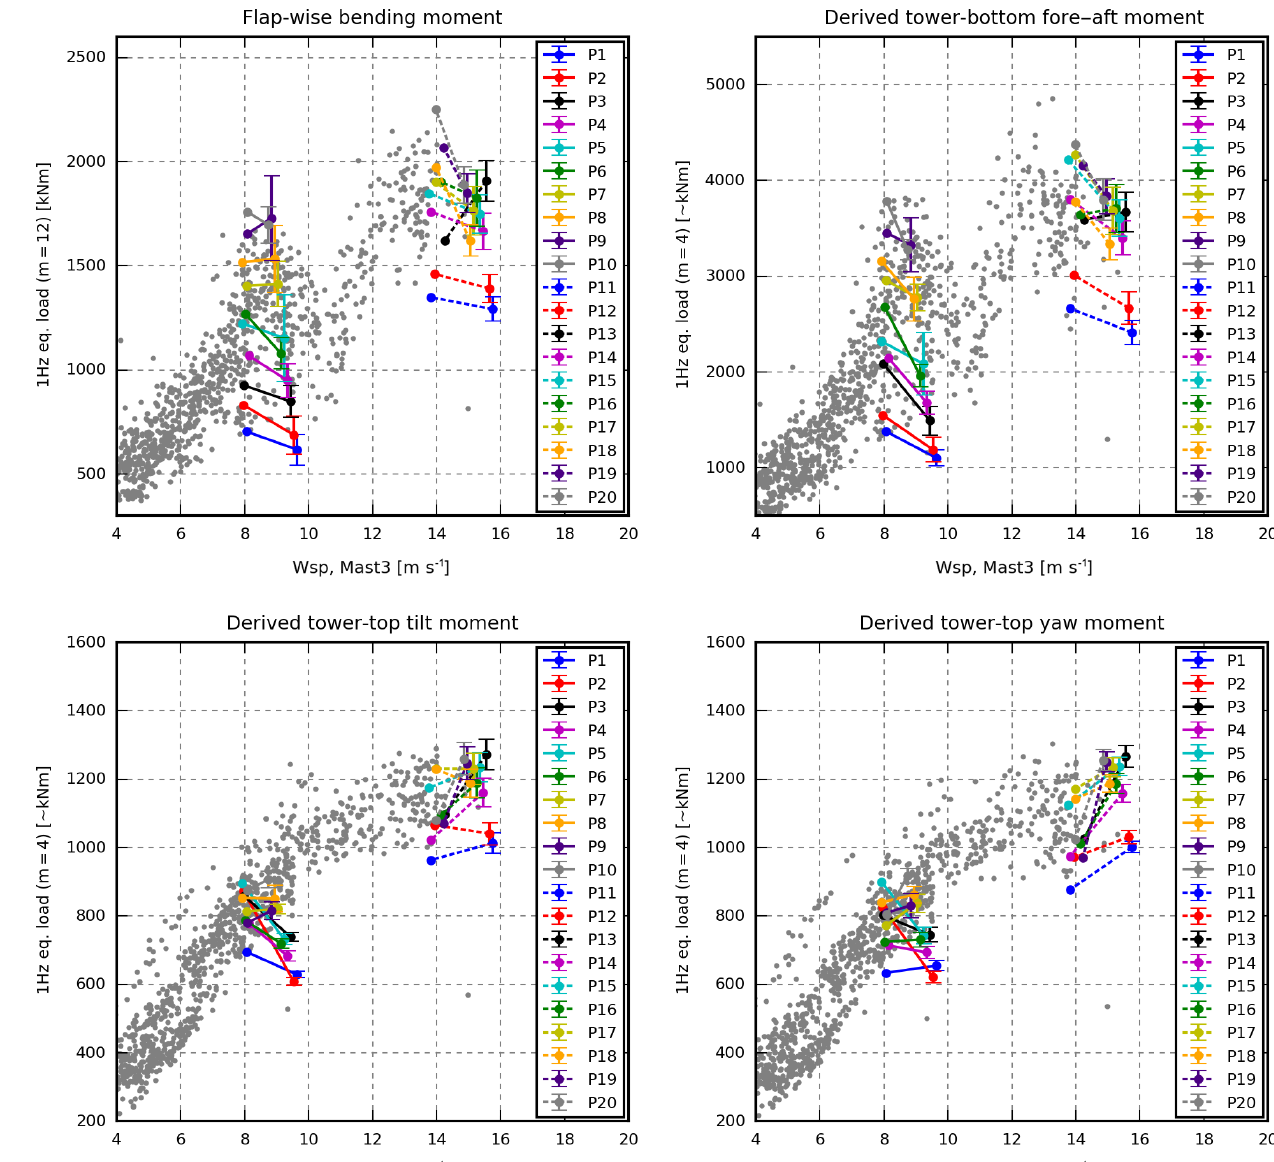
Figure 16. Case 4. Best case based on pitot-tube inflow information. For interpretation see Fig.